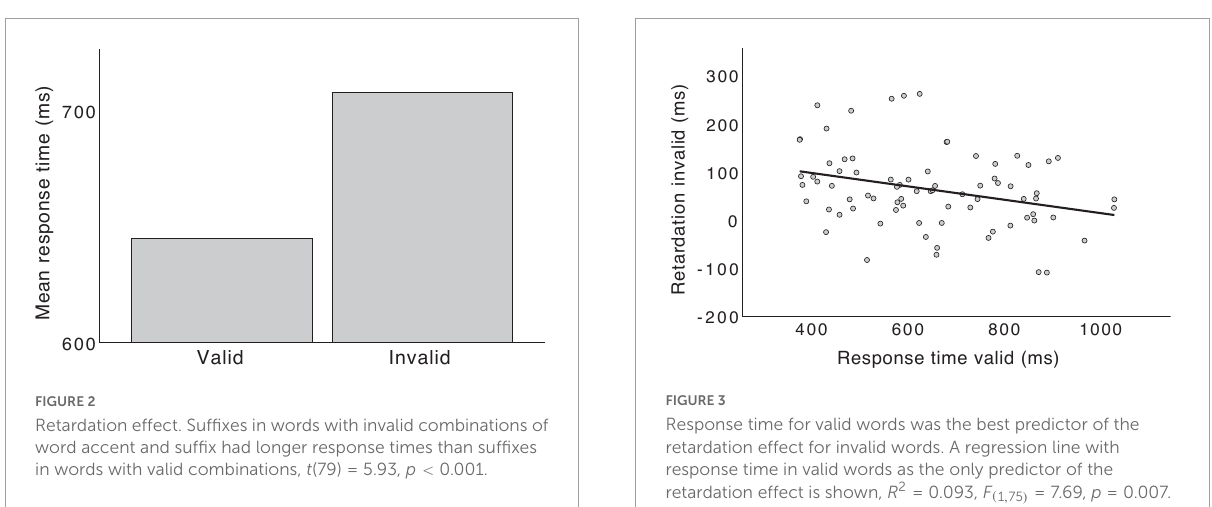
found: accent 1 in the stem has a greater retardation